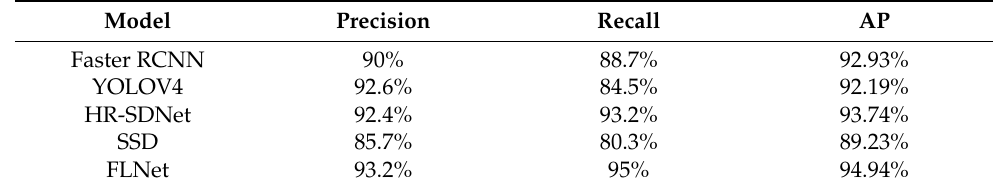
Table 4. Comparison results with other algorithms.